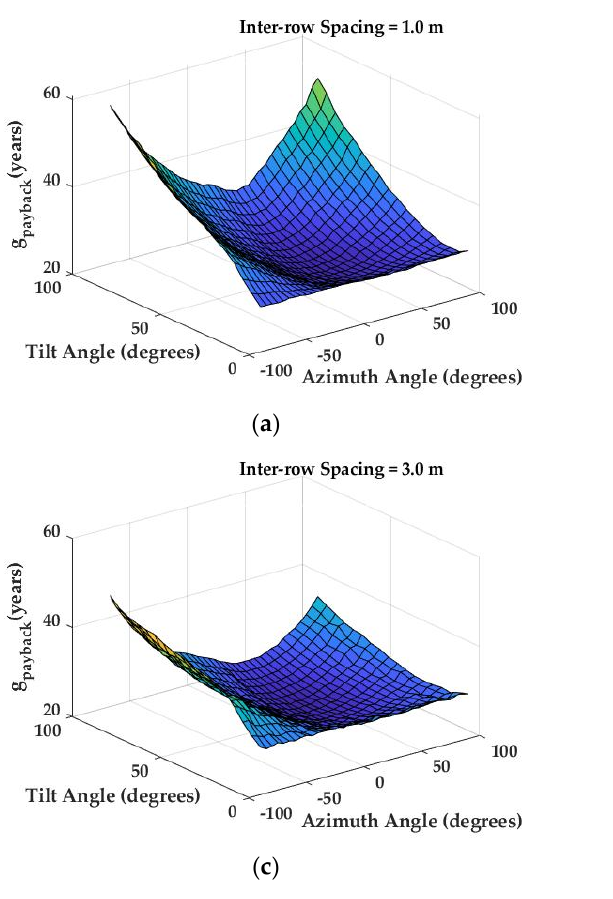
Figure 20. Objective function variation with tilt and azimuth angles for the ADMIN building for ( a ) L ir of 1.0 m, ( b ) L ir of 2.0 m, ( c ) L ir of 3.0 m, and ( d ) L ir of 4.0